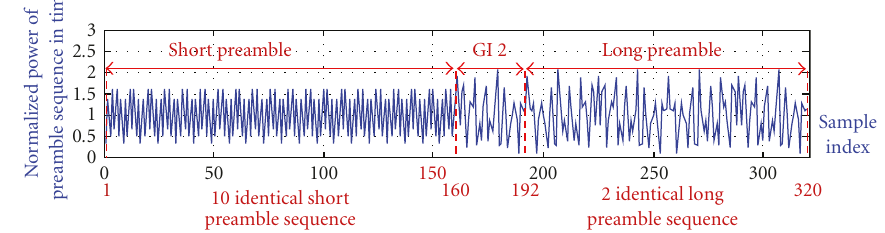
Figure 6: Normalized power signal of IEEE802.11a and IEEE802.11p preamble in time.